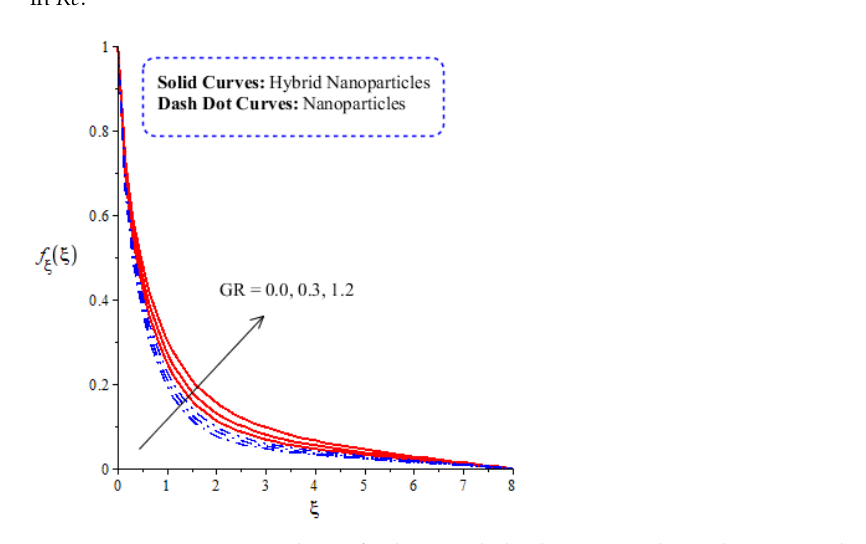
Figure 9. Comparative analysis of velocity in hybrid nanoparticles and nanoparticles versus change in 𝐺𝑅.